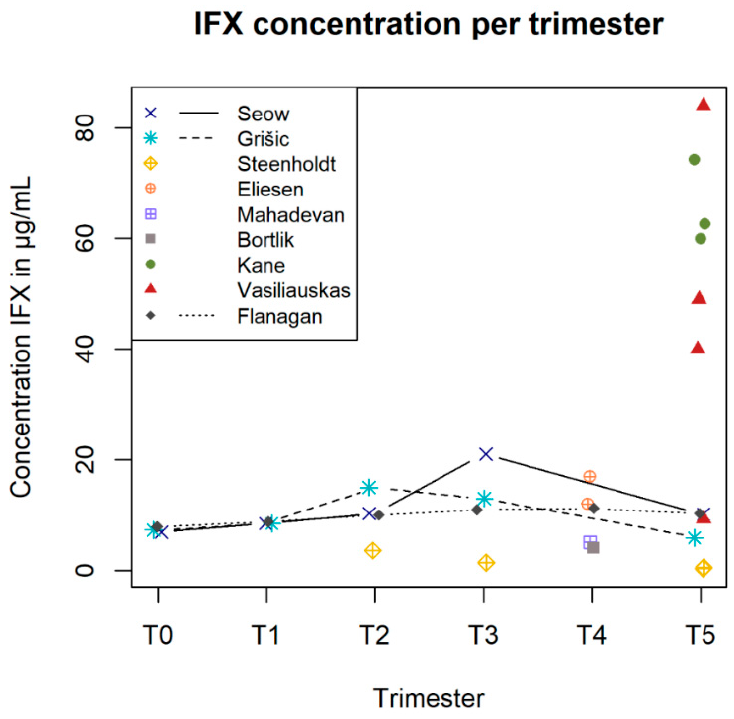
Figure 4. The concentrations of infliximab (IFX) from all available studies [13–21] in µ g/mL (shown on y -axis) during the different stages of pregnancy (shown on x -axis). The different states are expressed as pre-pregnancy (T0), trimesters one until three (T1, T2 and T3), delivery (T4) and postnatal (T5). In Figure 5, the ADL concentrations over time are provided. The authors [14,15] mentioned that the ADL concentration during pregnancy is relatively stable compared to the ADL concentration before and after pregnancy. It is, however, observed that pregnancy levels are lower than pre-pregnancy levels. Furthermore, the second trimester contains a discrepancy. No reason for this discrepancy was reported by the